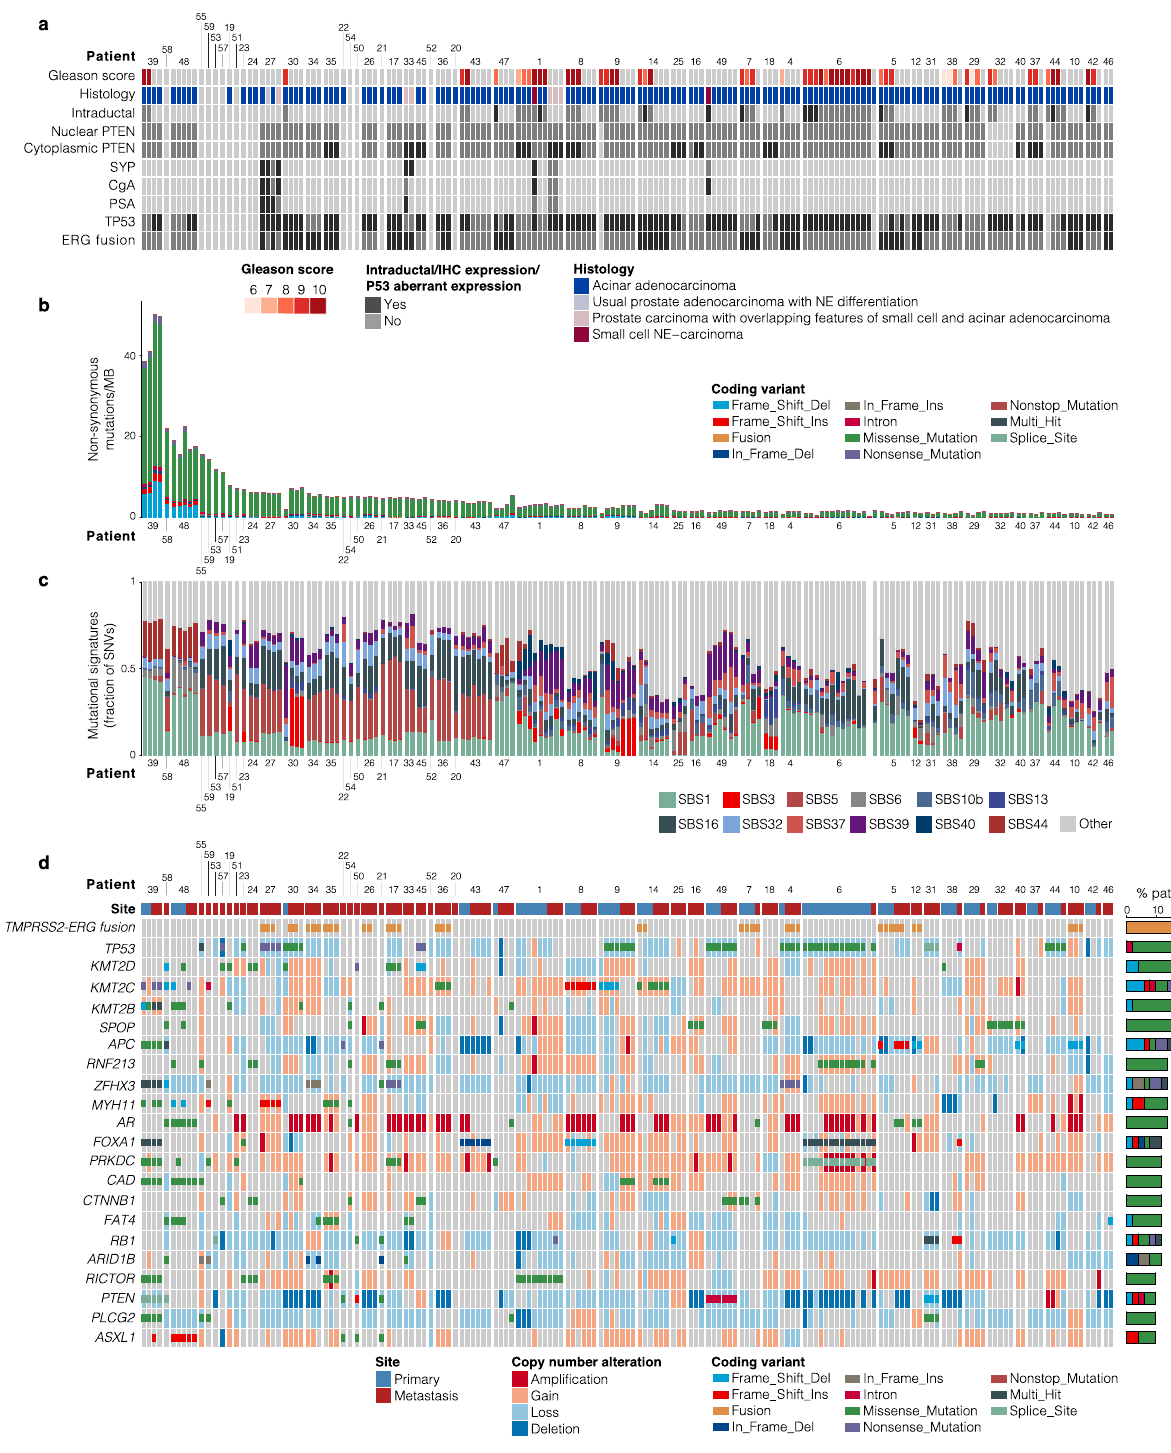
Fig. 1 Summary of histologic and genetic alterations in prostate cancer brain metastases. a Histology and immunohistochemistry results, b Summary of non-synonymous mutations/Mb. c Relative contribution of mutational signatures from COSMIC. d Summary of genes showing recurrent mutation or fusion (altered in >5 patients) from WES and targeted RNA-seq data. CNA are shown in large blocks, coding alterations in small blocks. Alteration types are colored according to the legend. Samples are grouped by patient and site (primary or metastasis). Source data are provided in Supplementary Tables 4 and